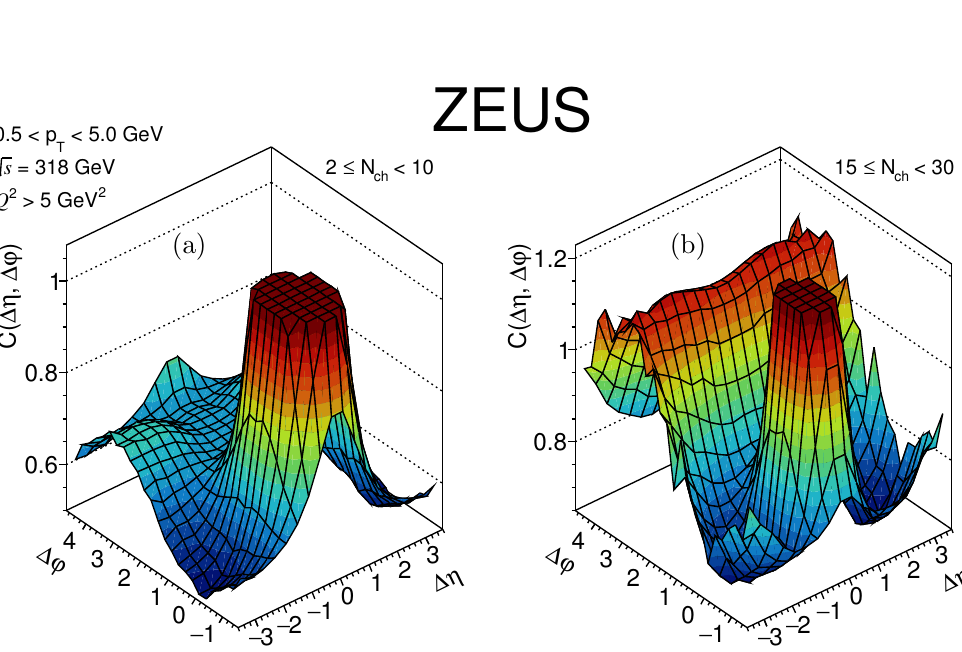
Figure 6 . Two-particle correlation C ((cid:1) (cid:17); (cid:1) ’ ) for (a) low and (b) high N ch . The peaks near the origin have been truncated for better visibility of the (cid:12)ner structures of the correlation. The plots were symmetrised along (cid:1) (cid:17) . No statistical or systematic uncertainties are shown.